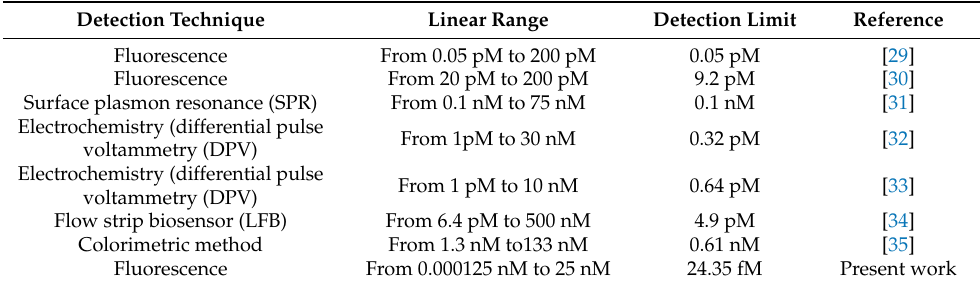
Table 2. Different methods for thrombin detection based on aptamer sensors.